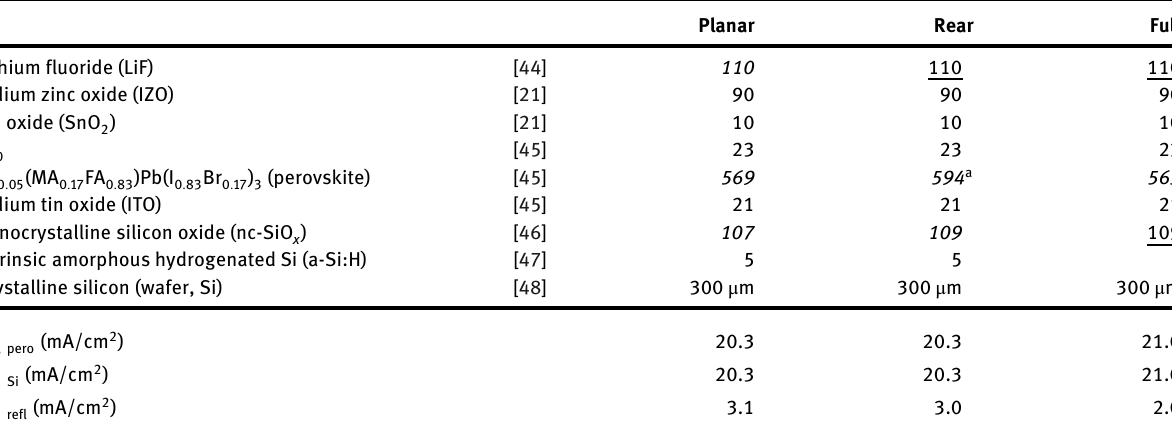
Table 3: The materials and layer thicknesses used for the optical simulations shown in Figure 2. All thicknesses (except Si) are given in nm, the italic thicknesses resulted from an optimization, and the underlined values were taken from a previous optimization. The sources for refractive index data are given. Further, the photo-current densities in the perovskite and silicon cells as well as the reflective losses are shown – for thetextureddevices thedata arefor nanotextureswith 750 nm period and40% aspectratio. For other periods and aspectratios, all layer thicknesses are the same except for perovskite.